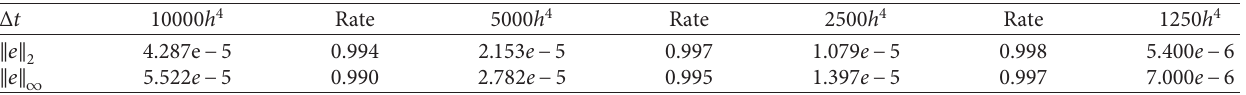
Table 8: Errors and convergence rates for the numerical results of the CN scheme at the final time T � 10 6 h 4 . Here, h � 1/128 is used. Δ t 10000 h 4 Rate 5000 h 4 ‖ e ‖